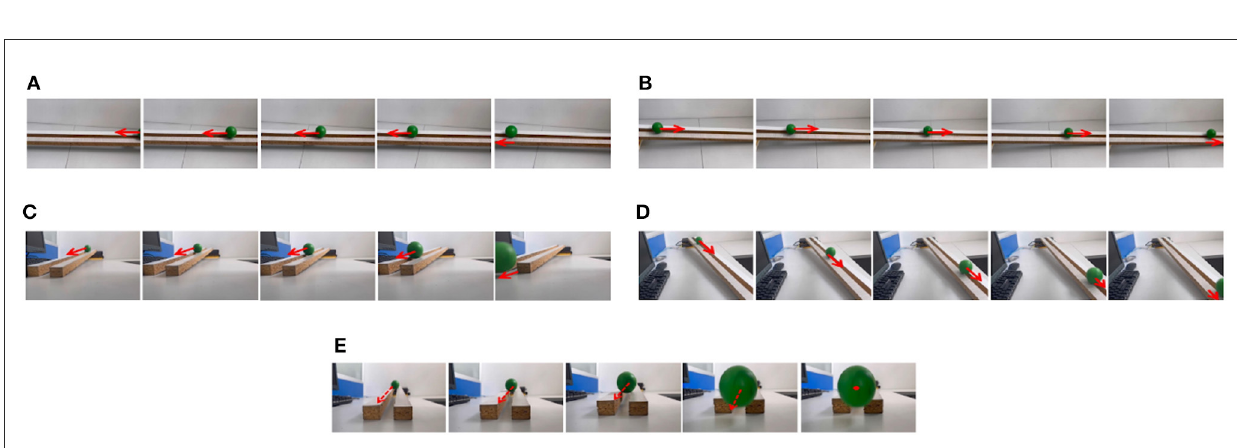
FIGURE9 Example frames of ball motion videos. (A) The ball moves to the left. (B) The ball moves to the right. (C) The ball moves downwards to the left. (D) The ball moves downwards to the right. (E) The ball is looming moving toward the